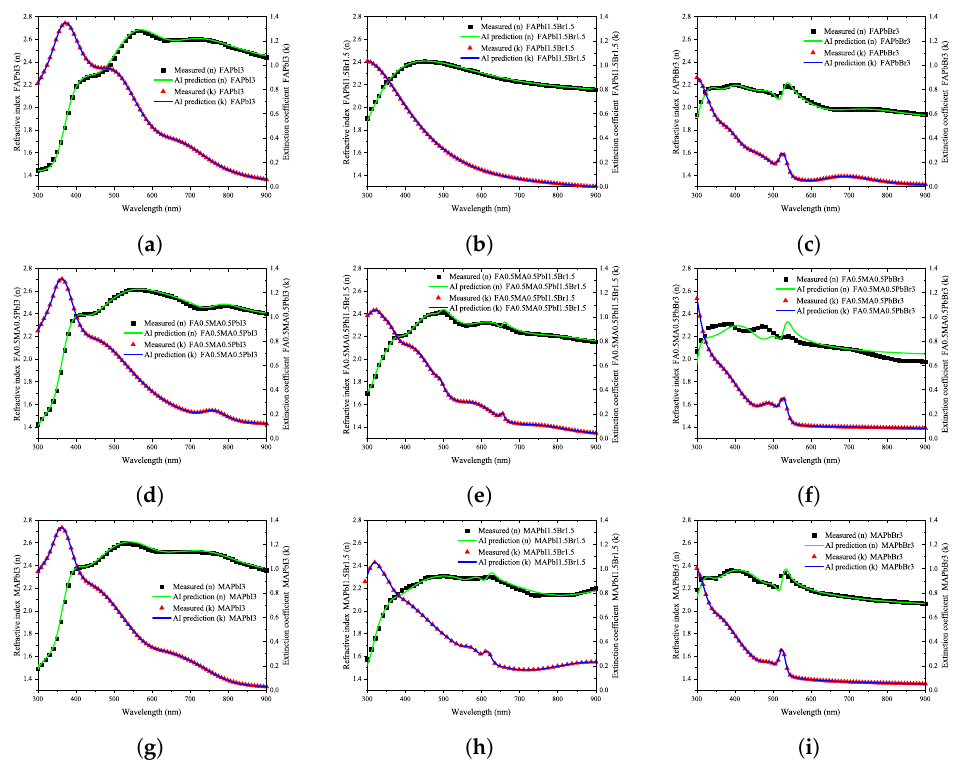
Figure 8. Refractive index and extinction coefficient through ellipsometry analysis of the qua- ternary perovskite material and comparison of the results of hyperregression analysis using artificial intelligence models: ( a ) FAPbI 3 , ( b ) FAPbI 1.5 PbBr 1.5 , ( c ) FAPbBr 3 , ( d ) FA 0.5 MA 0.5 PbI 3 , ( e ) FA 0.5 MA 0.5 PbI 1.5 Br 1.5 , ( f ) FA 0.5 MA 0.5 Br 3 , ( g ) MAPbI 3 , ( h ) MAPbI 1.5 Br 1.5 , ( i ) MAPbBr 3